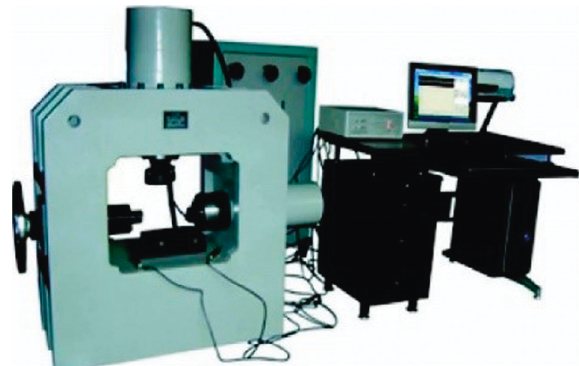
Figure 4: YZW1000 microcomputer-controlled electric direct shear instrument.